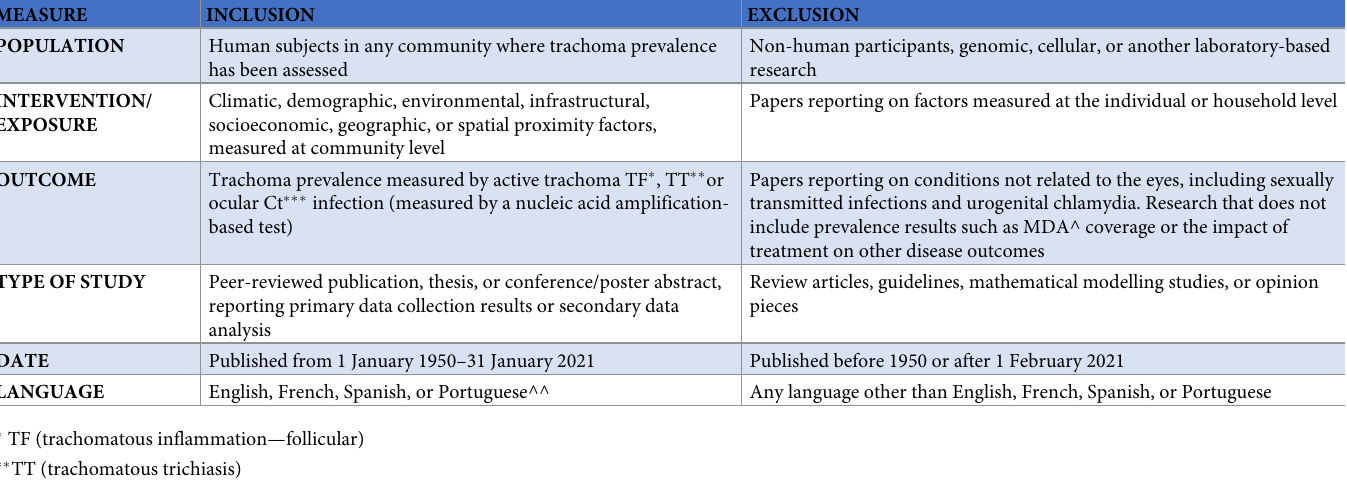
Table 1. Inclusion and exclusion criteria used for selecting studies for the full